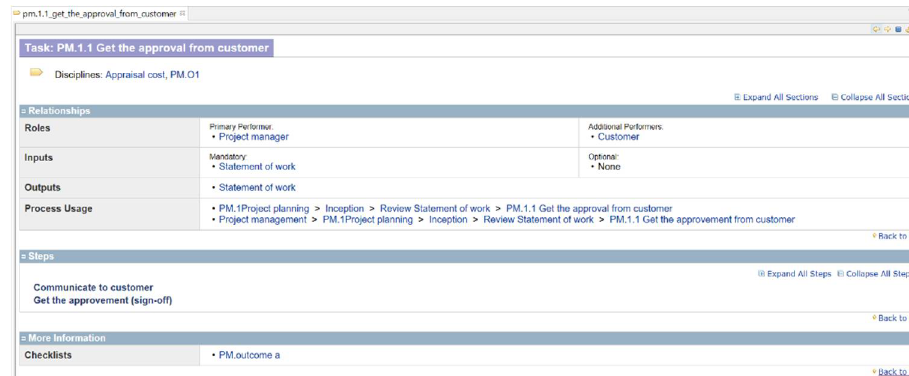
14 of 17 Figure 12. PM.1 (project planning) capability pattern. Figure 13. The detailed activity diagram for the PM.1.1 task. The task description of PM1.1 is shown in Figure 14. It defines the related elements of this task, including discipline, role, work product (input and output), process usage, step, and checklist. The project manager is the primary performer who executes this task, whereas the customer is an additional performer who also contributes to the accomplish- ment of the task. The statement of work is a work product, representing the input and the